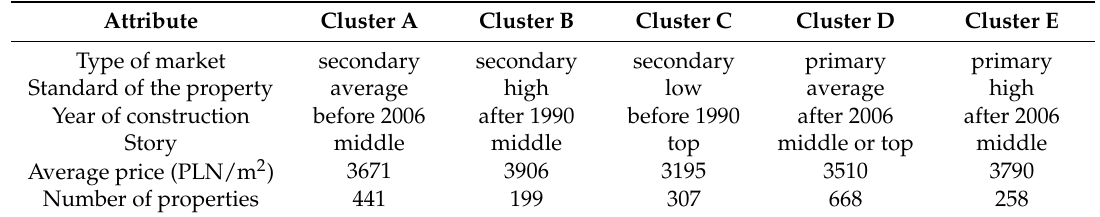
Table 3. Characteristics of the separated property clusters.